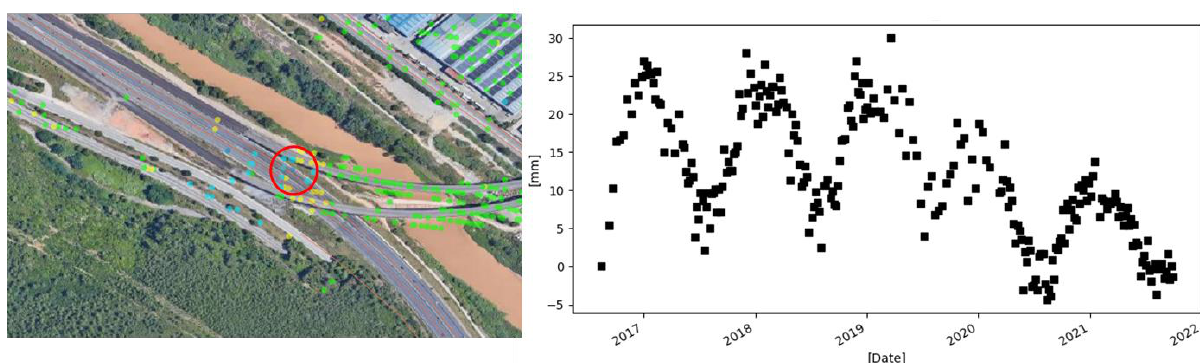
Figure 11. Examples of thermal